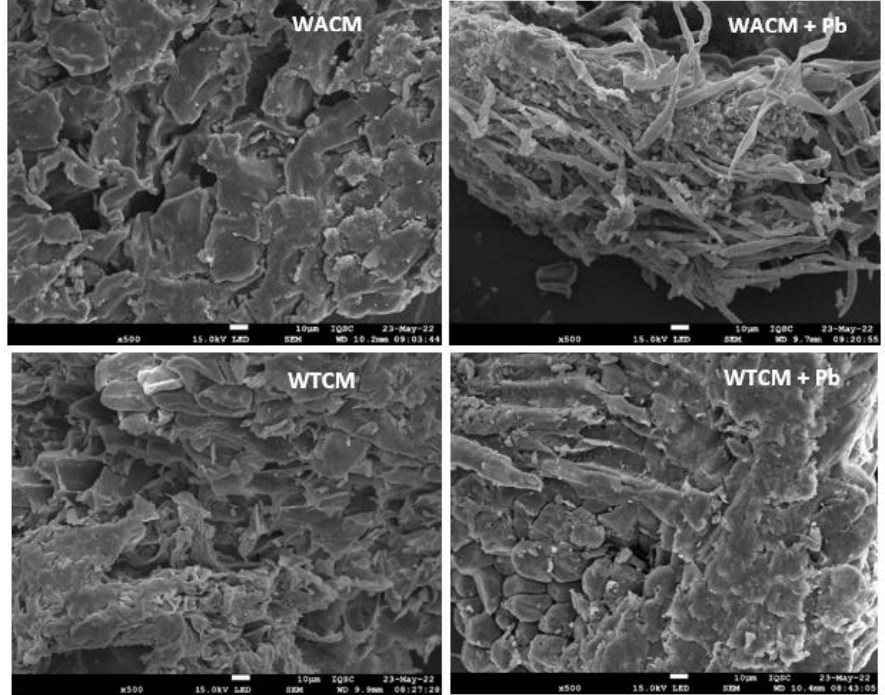
Figure 2. SEM of WACM and WTCM before ( left ) and after ( right ) Pb(II) biosorption. pH = 4, C 0 = 130.8 mg L −1 , T = 293 K, t = 120 min.